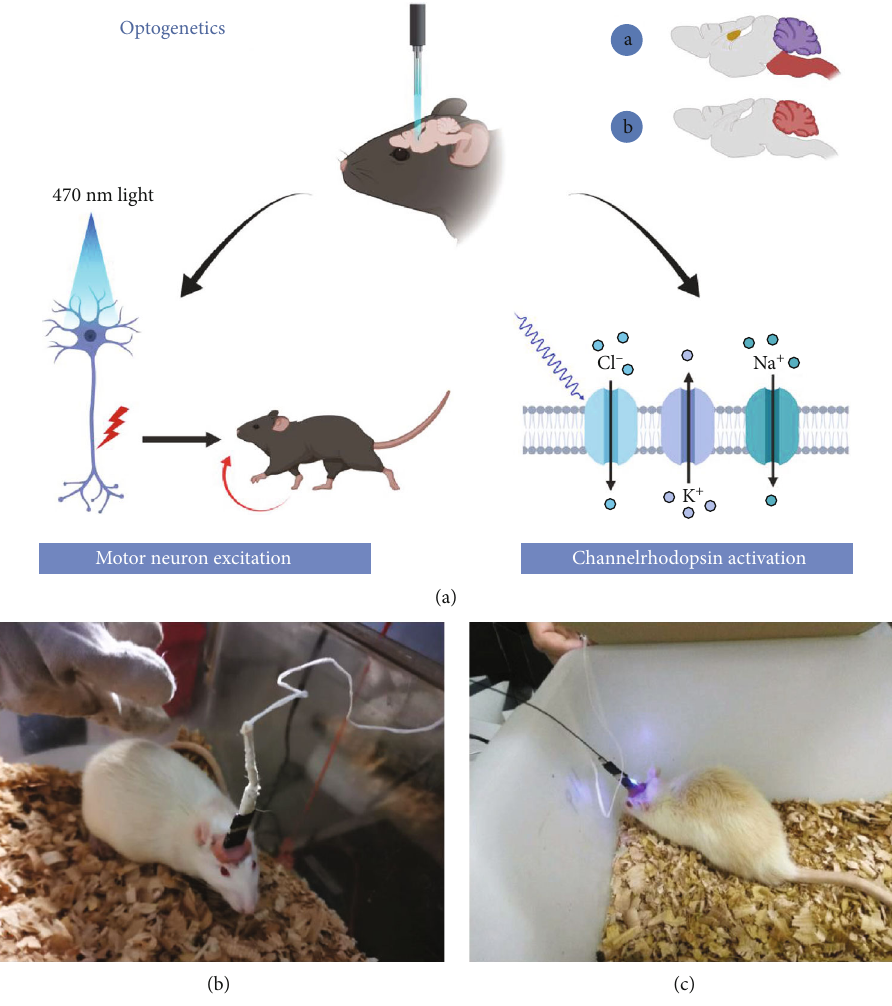
Figure 2: (a) The whole process of optogenetic expression. After virus injection, the channel protein was opened under 470 nm blue light irradiation. At this time, the ions in the host cell fl ow across the membrane, causing the neurons to excite. Photograms of the rat with laser (b) o ff and (c)